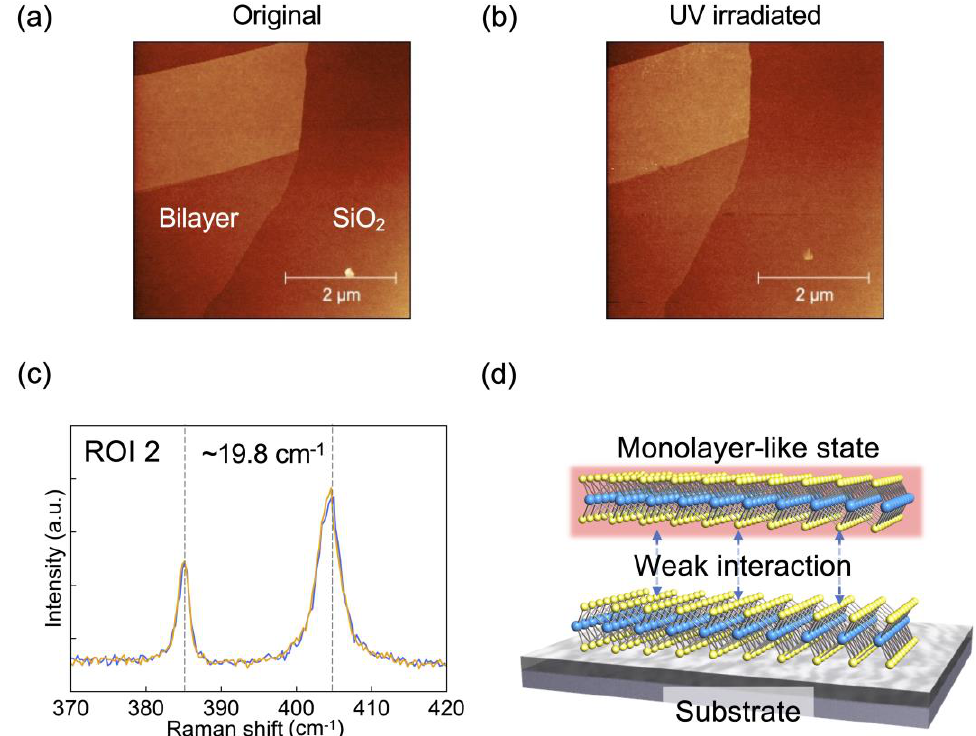
Figure 5. ( a , b ) Atomic force microscope (AFM) images for ( a ) the as-exfoliated (original) bilayer MoS 2 exfoliated with the weight and ( b ) the UV-irradiated bilayer MoS 2 . ( c ) Raman spectra for the original (blue) and the UV-irradiated (orange) bilayer MoS 2 in ROI 2 in Figure 3. ( d ) Illustrative image of a plausible state of the bilayer MoS 2 . The top layer would show a monolayer-like state due to the weak interaction between the top and bottom layers by a sort of misalignment of each layer.